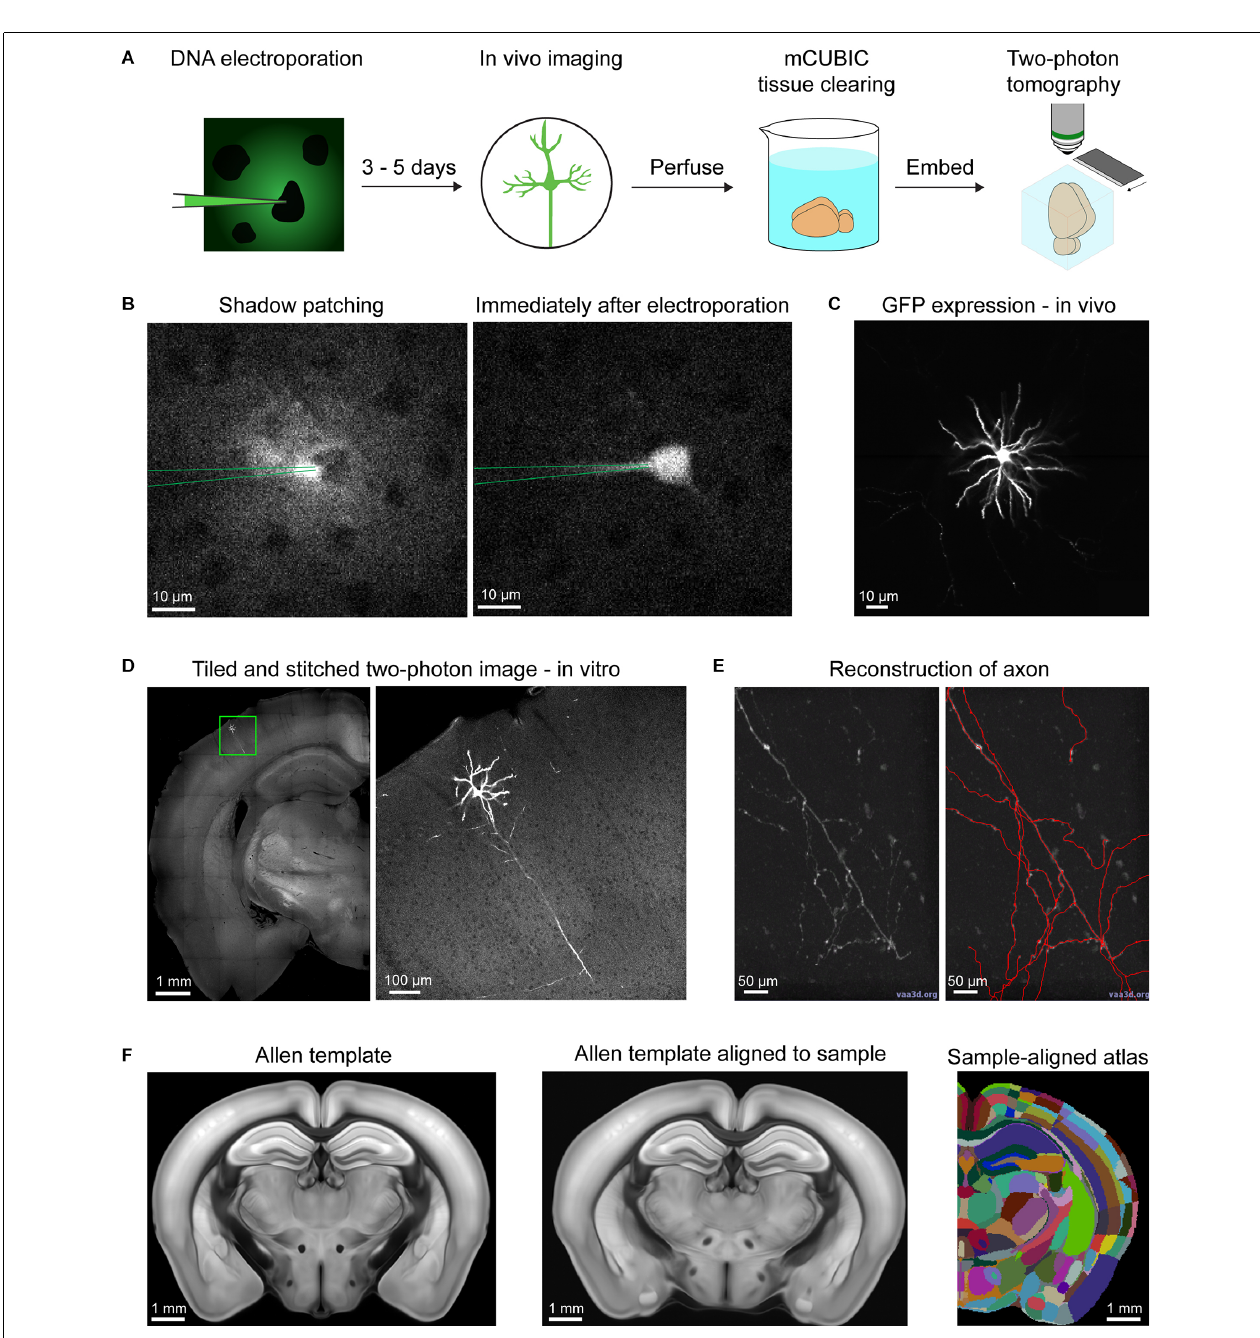
FIGURE 1 | Acquisition and analysis pipeline for single-cell reconstruction. (A) Shadow electroporation labels a single neuron by introducing GFP plasmids. After 3–5 days of expression time, the cell was viewed through a cranial window under a two-photon microscope to control for GFP expression and the absence of any sign of apoptosis. Animals were then perfused and the brain was cleared in a modified CUBIC solution. Finally, the sample was embedded in agarose and imaged under a two-photon tomographic microscope. (B) Example snapshots of an electroporation session. Left , fluorescent dye from the electroporation pipette fills the extracellular space revealing cell bodies as shadows in the image. The pipette approaches and contacts a randomly selected neuron. Right , following electroporation, the fluorescent dye rapidly fills the cell indicating successful pipette content delivery into the cell. (C) Quality check of the labeled neuron through the cranial window before perfusion. (D) Example image acquired from two-photon tomography. Left , a coronal section with a region of interest near the cell body. Right , the region of interest at higher resolution, showing the cell body, its dendrites, and its main descending axon. (E) Semi-automatic neuron reconstruction using Vaa3d. Left , an example region with axon in Vaa3d. Right , the same region with annotations (red) highlighting the axon. (F) Alignment with the Allen Mouse CCFv3. Left , a coronal section of the CCFv3 template. Middle , the template deformed to align with the sample space. Right , the CCFv3 atlas deformed in the same way as the template to match the sample